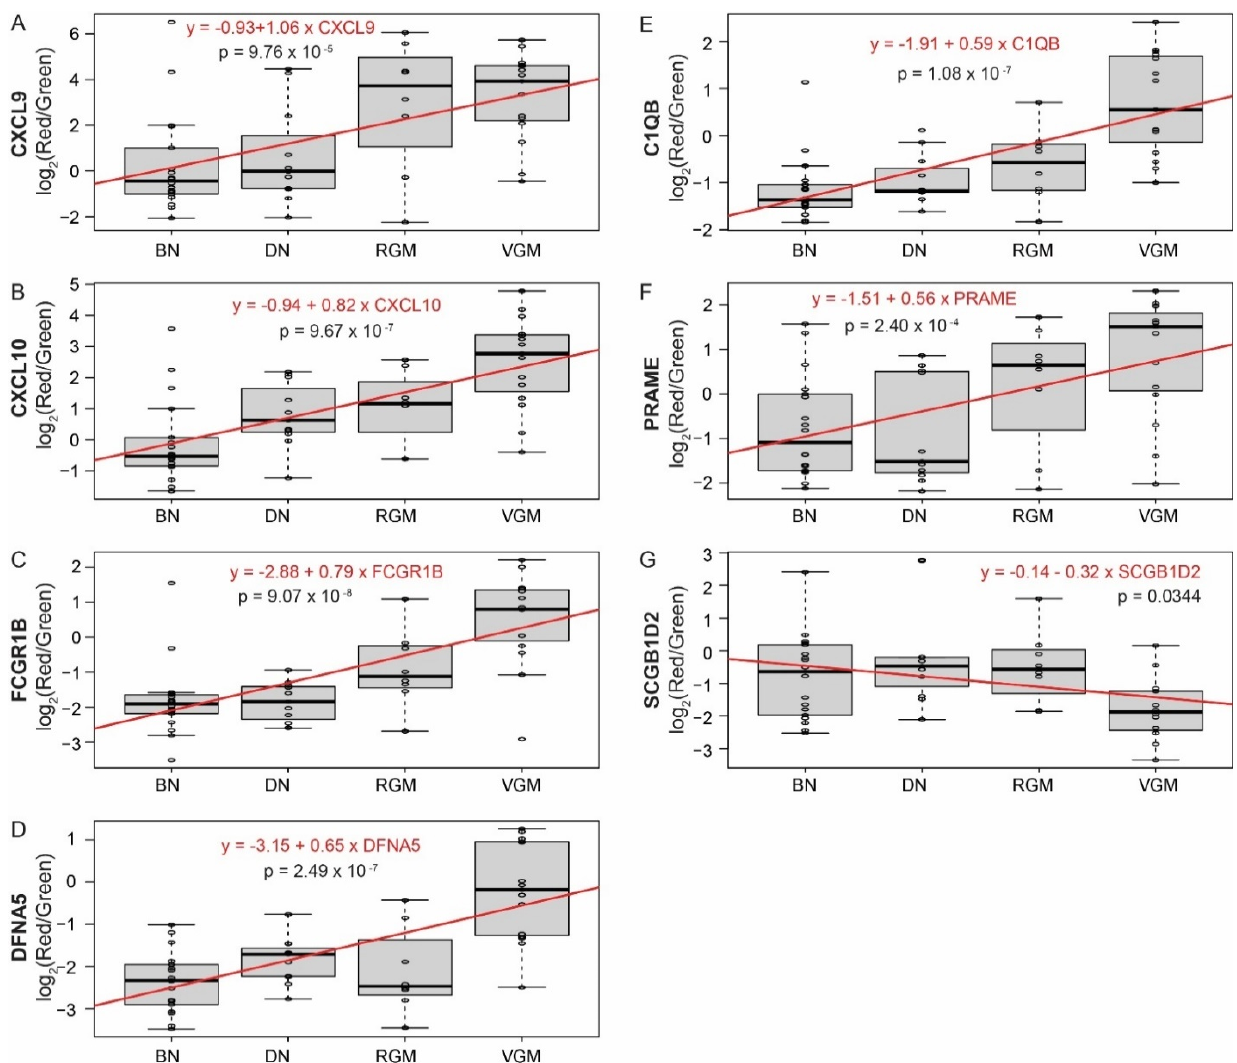
Figure 4. Linear change in expression of CXCL9, CXCL10, FCGR1B, DFNA5, C1QB, PRAME, and SCGB1D2 across lesions in the spectrum of melanoma progression. Linear regression between lesion type and indicated gene expression in the Scatolini dataset. ( A ) CXCL9, ( B ) CXCL10, ( C ) FCGR1B, ( D ) DFNA5, ( E ) C1QB, ( F ) PRAME, and ( G ) SCGB1D2. The bold line in the box plot indicates the median; the upper and lower limits of the boxes indicate the 75th and 25th percentiles, respectively. The lower and upper whiskers indicate the minimum and maximum. Dots outside of the box and whiskers indicate outliers. The red line demonstrates the linear model fit between lesion type and gene expression; the equation of the linear regression is included in the red text. p -values indicate the significance of the association between the lesion type